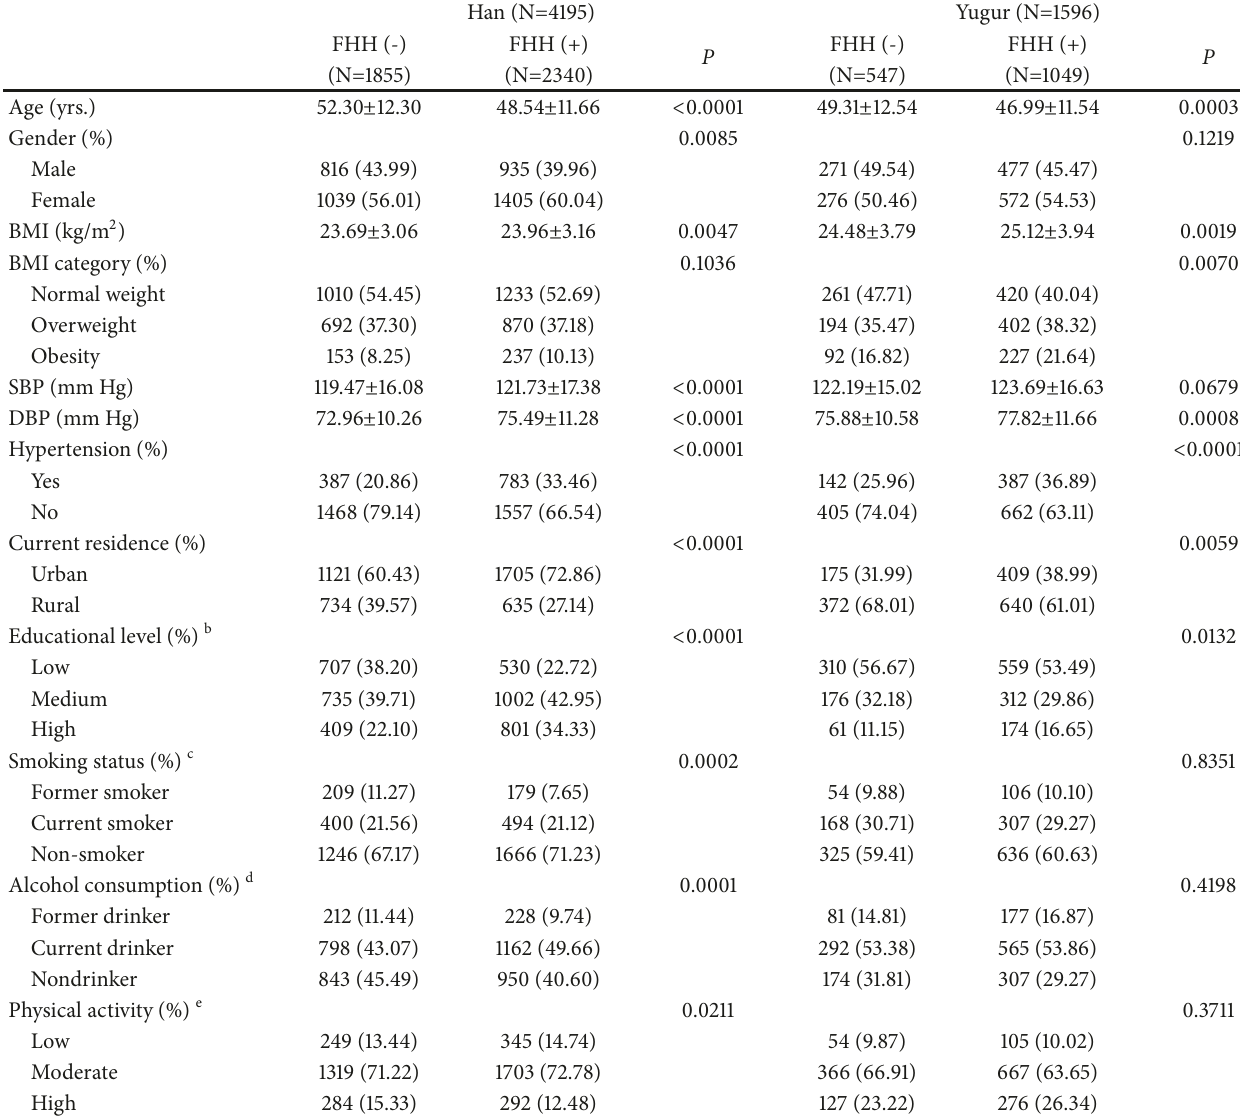
Table 1: Demographic characteristics of 5791 participants by ethnicity and FHH in China.